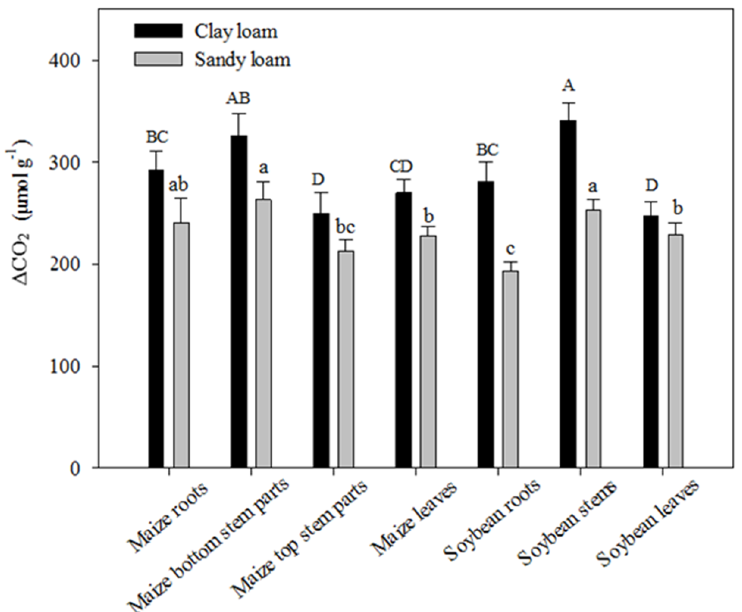
Figure 3. The cumulative increase of CO 2 emission ( ∆ CO 2 ) (61-day incubation) of clay loam and sandy loam soils amended with different crop residues. ∆ CO 2 = C R,SOC − C SOC , C R, SOC is the cumulative CO 2 emission from soils with residue amendment while C SOC is the cumulative CO 2 emission from soils without residue after the incubation of 61 days. Different uppercase and lowercase letters indicate significant differences among residue types in the clay loam and sandy loam, respectively, at p ≤ 0.05. Vertical bars are the standard errors ( n = 4).